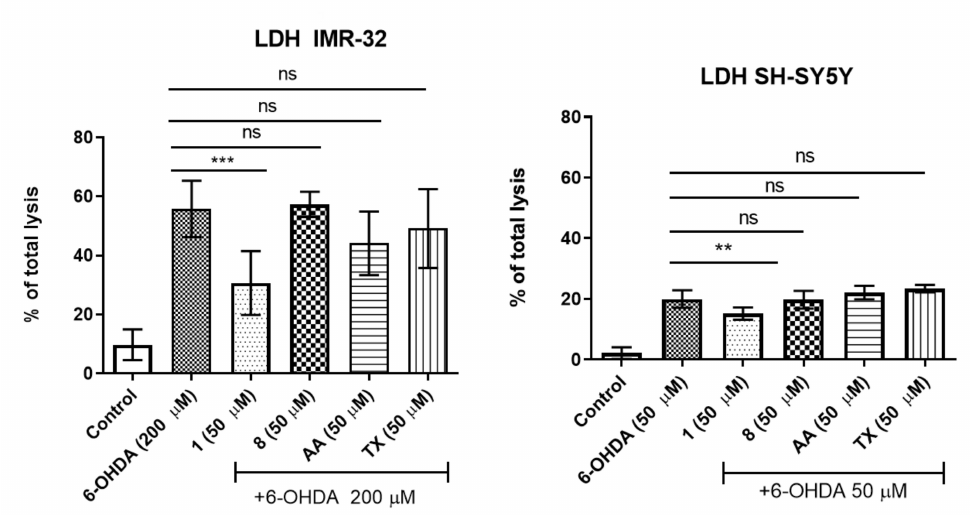
Figure 2. Neuroprotection studies of compounds 1 and 8 (50 µ M) against 6-OHDA-induced LDH release from necrotic cells. Ascorbic acid (AA, 50 µ M) and Trolox (TX, 50 µ M) were used as the reference antioxidants. Statistical significance was evaluated by one-way ANOVA, followed by Bonferroni’s comparison (ns—not significant, ∗∗ p < 0.01, ∗∗∗ p < 0.001 compared with the positive control: 200 µ M or 50 µ M of 6-OHDA).